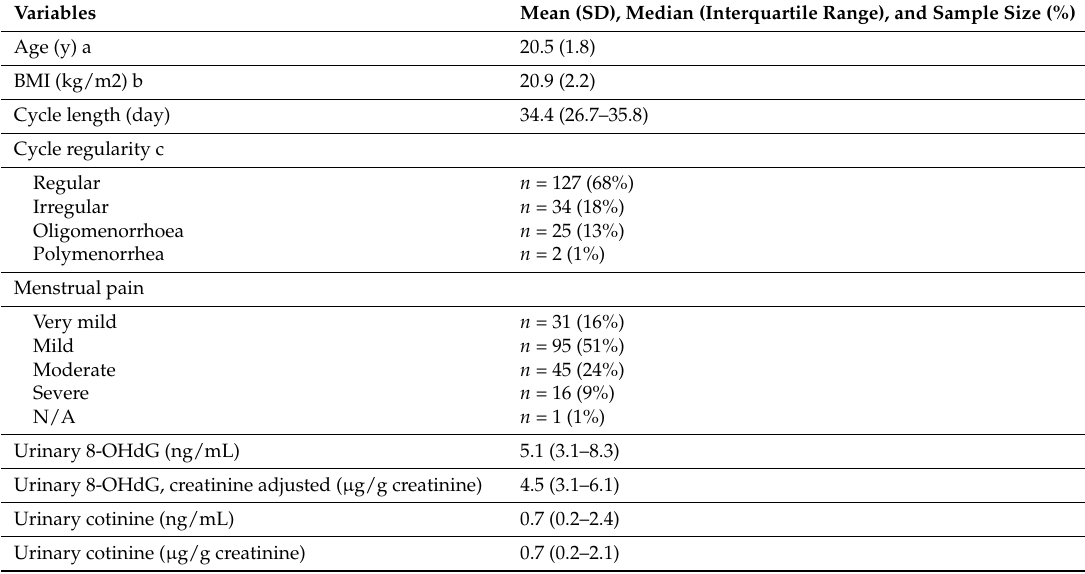
Table 1. Basic characteristics of the participants ( n = 188).